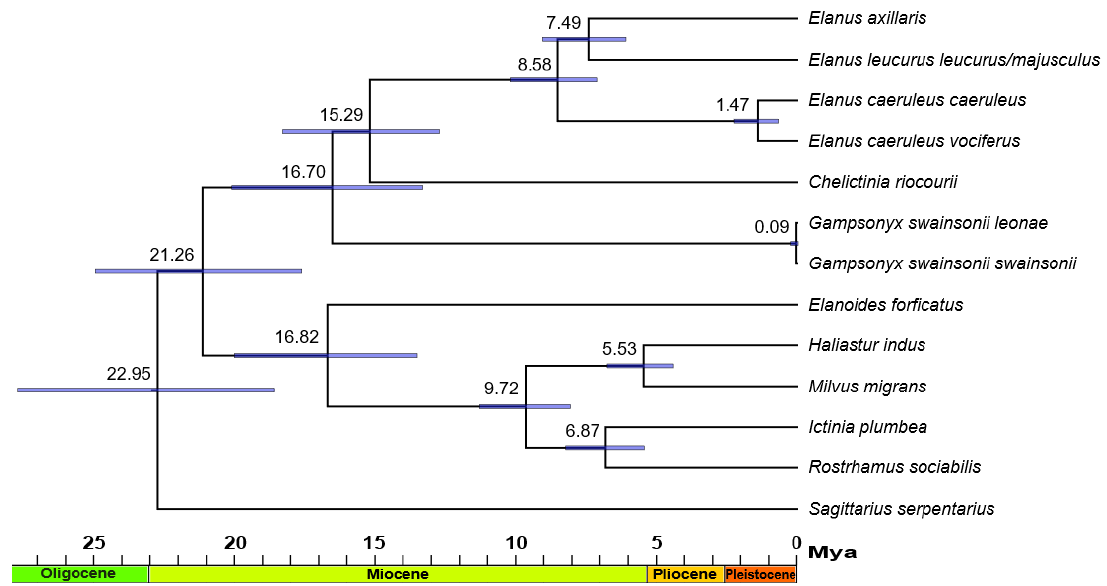
Figure 3. Phylogeny of elanins and other selected kites based on Bayesian Inference of the concatenated mitochondrial dataset. The secretarybird is an outgroup, node ages in million years ago are indicated on the branches. Node bars show the 95% highest posterior density of nodal age estimates.